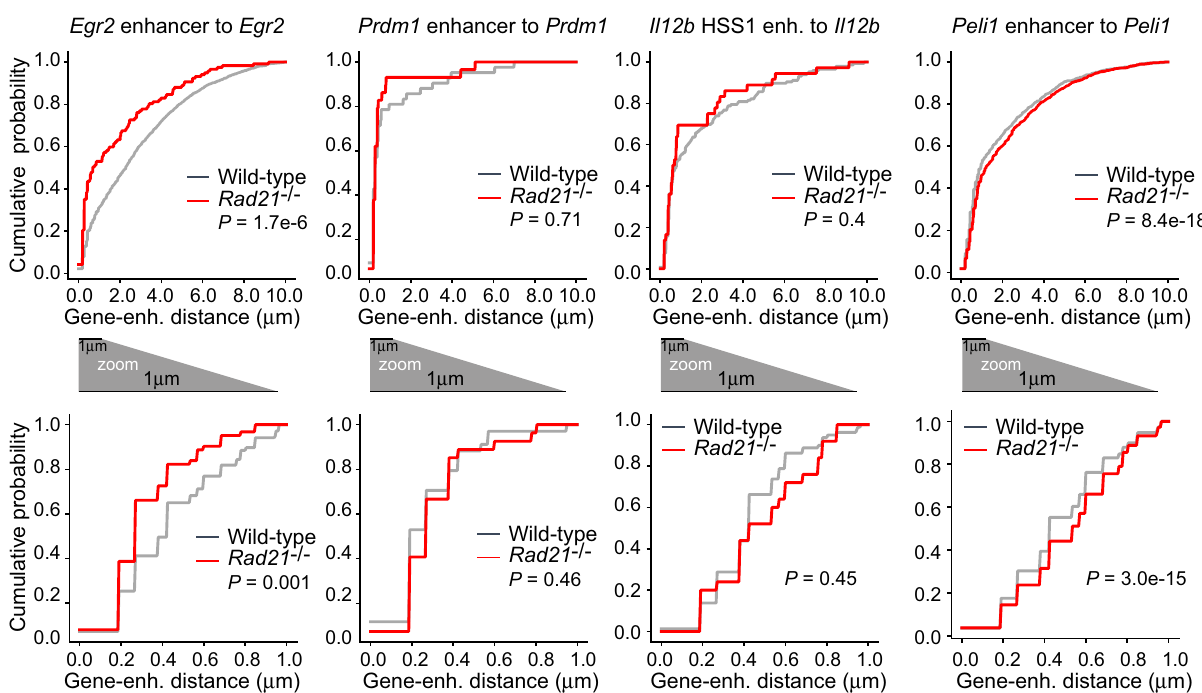
Fig. 8 Similar enhancer – promoter distances in wild-type and cohesin-de fi cient macrophages. Cumulative distances between enhancer and promoter smRNA-FISH signals in LPS-activated macrophages at the indicated loci. Number of wild-type cells: 8382 ( Egr2 ), 3985 ( Prdm1 ), 16,604 ( Il12b ), 19,864 ( Peli1 ), at least three biological replicates per locus. Number of Rad21 − / − cells: 7658 ( Egr2 ), 3992 ( Prdm1 ), 7352 ( Il12b ), 18,600 for Peli1 ), at least three biological replicates per locus. Top: all observed distances. Number of wild-type gene-enhancer pairs: 1754 ( Egr2 ), 59 ( Prdm1 ), 370 ( Il12b ), 5004 ( Peli1 ). Number of Rad21 − / − gene-enhancer pairs: 128 ( Egr2 ), 35 ( Prdm1 ), 43 ( Il12b ), 4288 ( Peli1 ). Bottom: Distances up to 1 μ m. Number of wild-type gene- enhancer pairs: 534 ( Egr2 ), 23 ( Prdm1 ), 116 ( Il12b ), 1440 ( Peli1 ). Number of Rad21 − / − gene-enhancer pairs: 52 ( Egr2 ), 20 ( Prdm1 ), 19 ( Il12b ), 956 ( Peli1 ). P values < 0.05 indicate that two cumulative distributions are different by the two-sided Kolmogorov – Smirnov